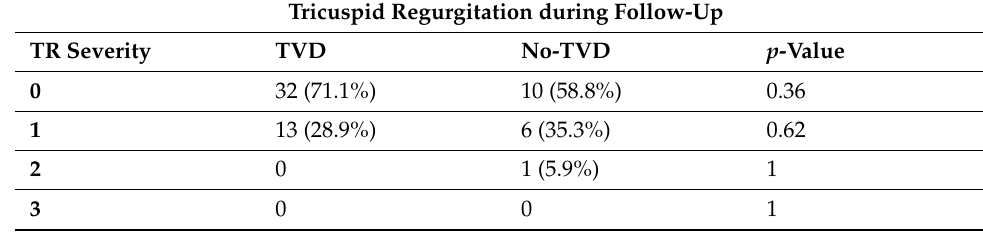
Table 3. Tricuspid regurgitation in patients during